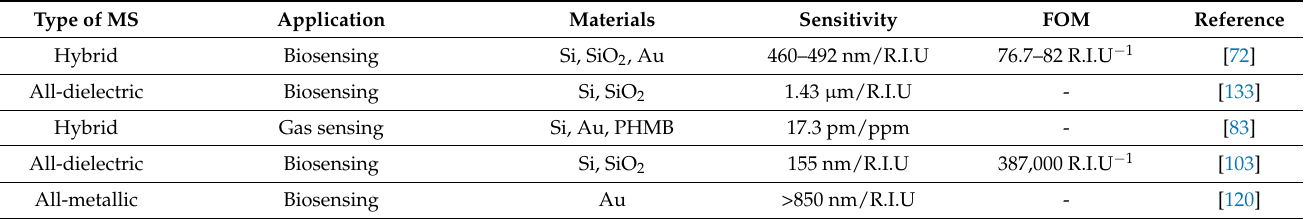
Table 1. Performance comparison of all-dielectric, all-metallic, and hybrid-MS-based